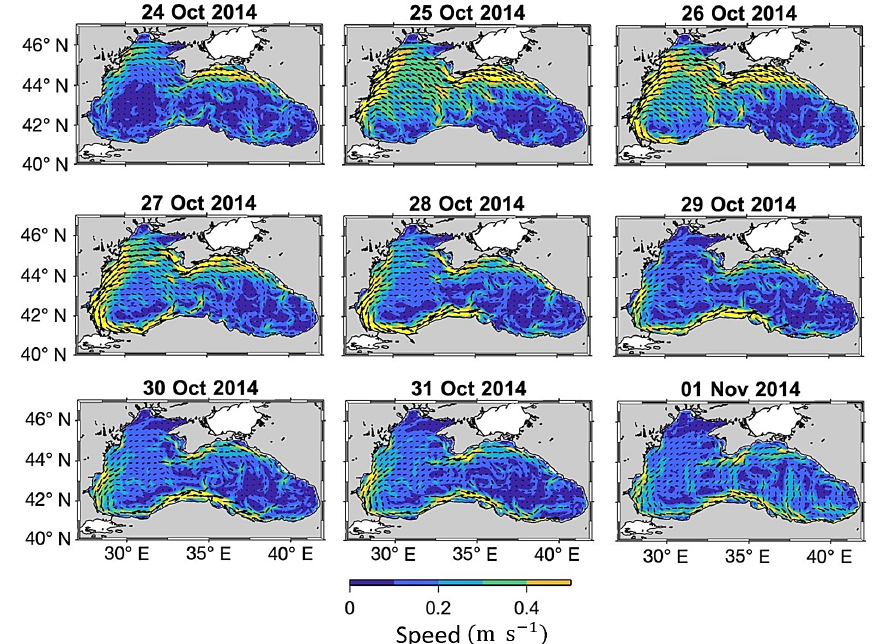
Figure 10. Sequence of daily mean horizontal velocity distributions at 2.5m from 24 October to 1 November 2014, obtained from the Black Sea reanalysis product of CMEMS. For clarity of presentation, only 1 of every 10 vectors is plotted.